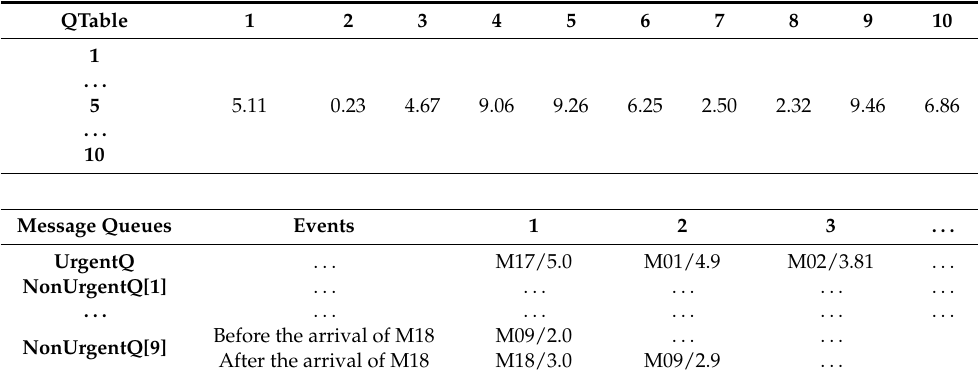
Table 3. Contents of QTable and message queues at unit time